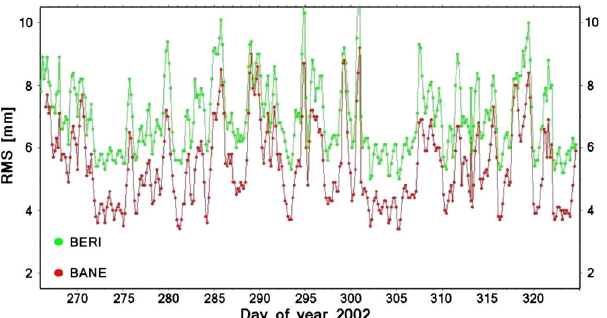
Fig. 8. Time evolution of the average amount of post-fit phase resid- uals (RMS) per 12h session (6 evaluations per day) throughout the measurement campaign in autumn 2002, for the two close-by sta- tions BANE and BERI.